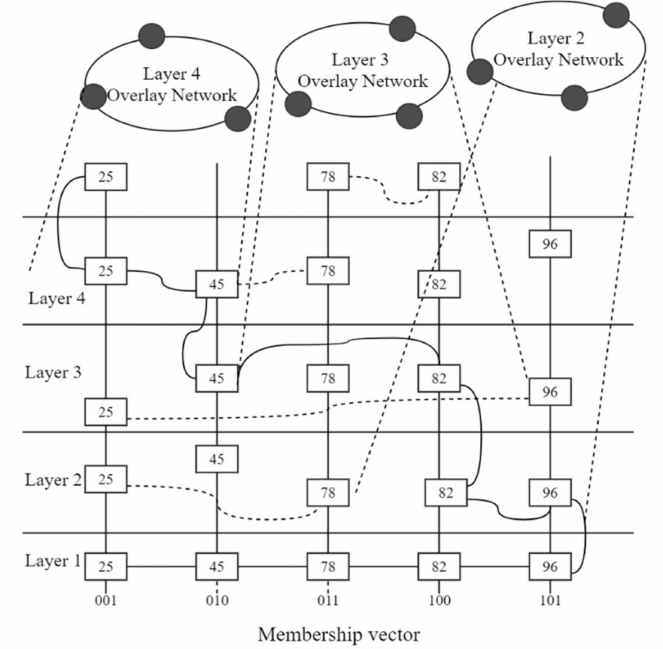
Figure 8. General Architecture of a Hierarchical Skip Graph Overlay